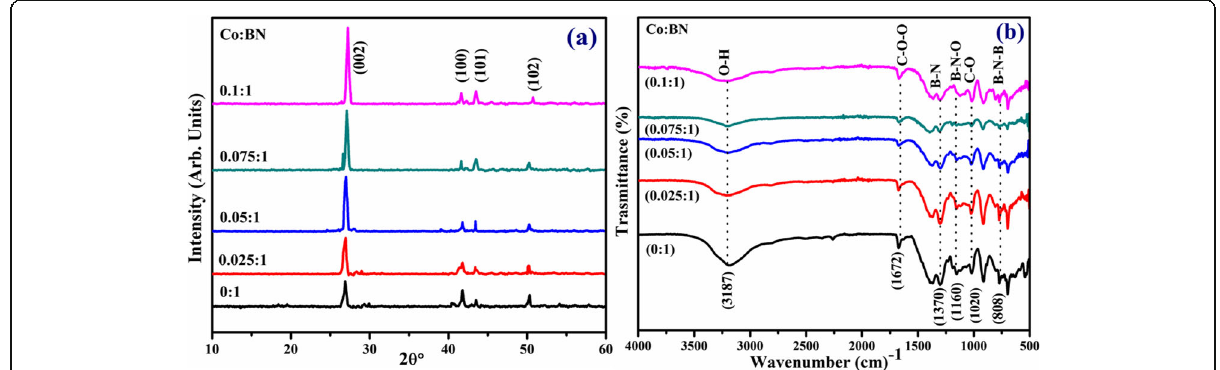
Fig. 3 a XRD patterns of pristine and various concentrations (2.5, 5, 7.5, and 10 wt%) of Co-doped BN-NS. b FTIR